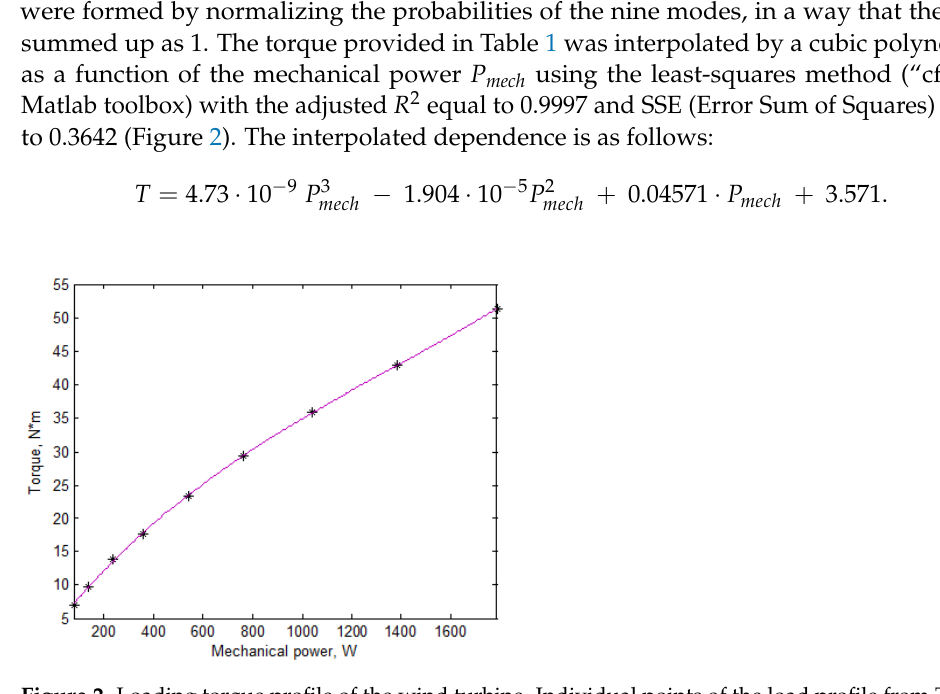
Figure 2. Loading torque profile of the wind turbine. Individual points of the load profile from Table 1 are marked with asterisks. The polynomial interpolation dependence is shown with the solid line. Table 2. Substituting two-mode profile.